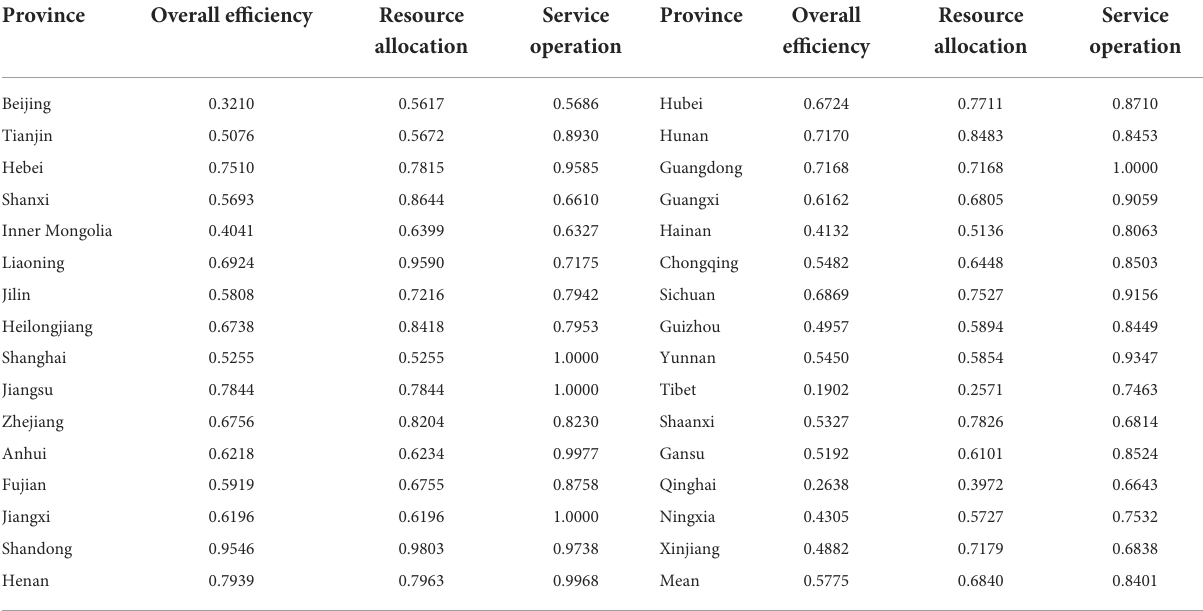
TABLE 4 Average efficiency of health system at different stages in each province. Province Overall efficiency Resource